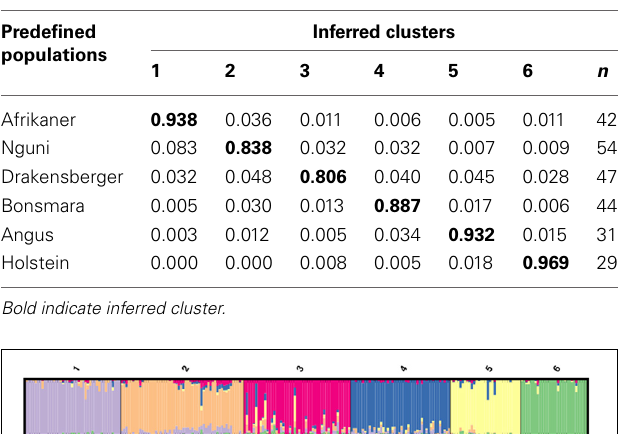
Table 4 | Proportion of membership of the analyzed South African cattle breeds in each of the six clusters inferred in the ADMIXTURE program.